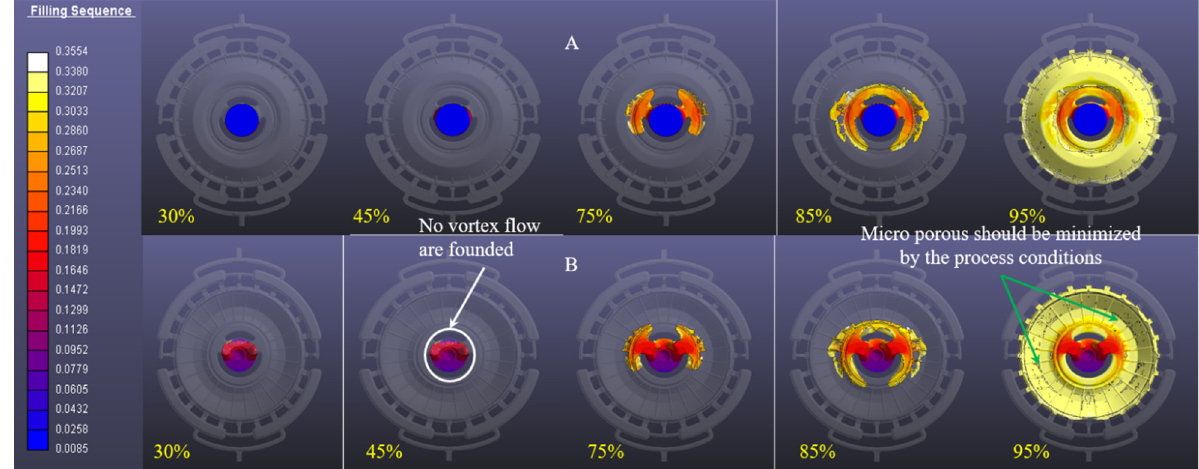
Figure 11. Simulation results with the final casting layout: ( A ) Fixed side; ( B ) Moving side.